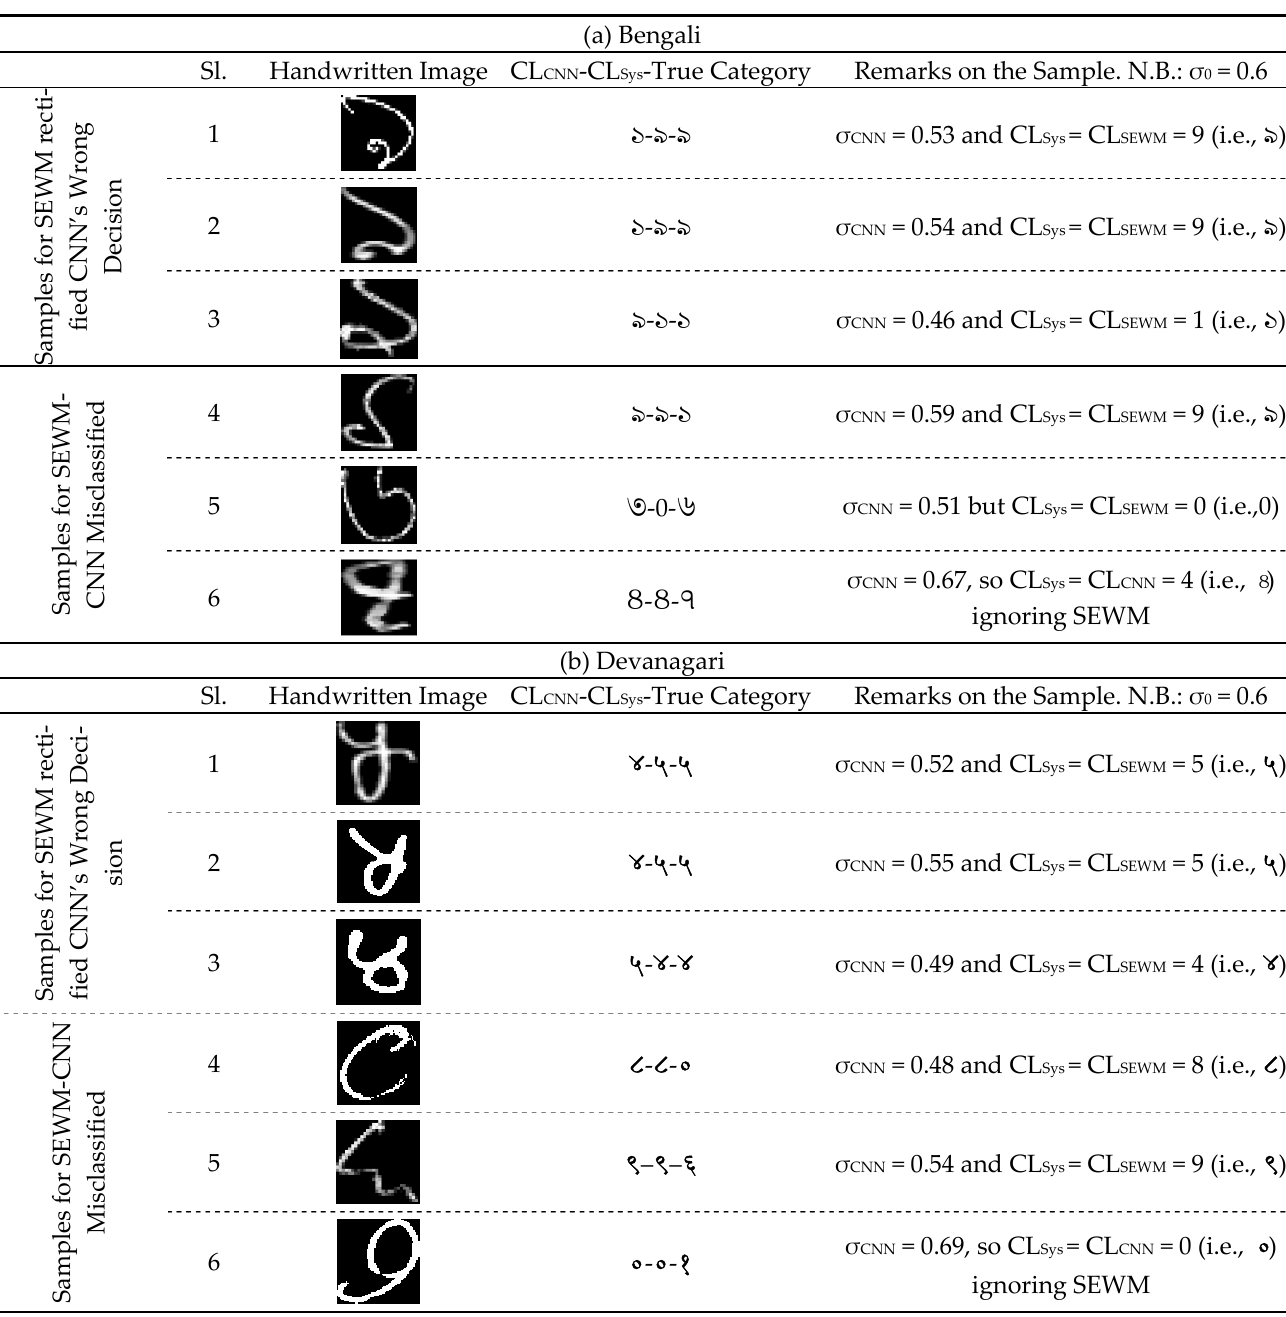
Table 4. Proficiency of SEWM-CNN comparing CNN on selected test samples. (a) Bengali